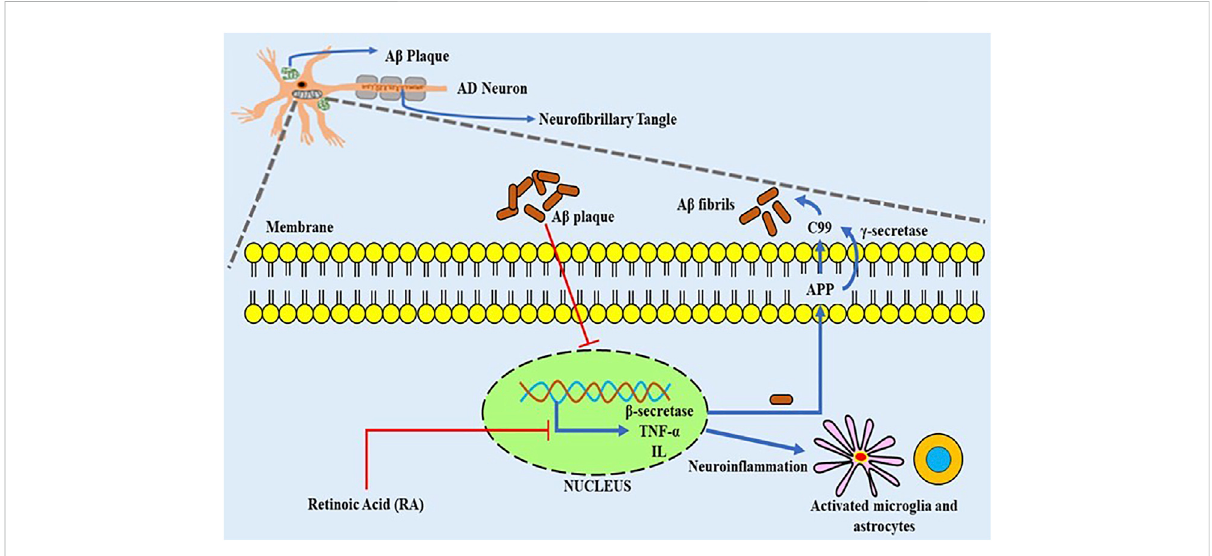
FIGURE 2 The overactivation of the ß- and Γ -secretases complexes may lead to the formation of Aß fi brils which successively leads to the generation of amyloid-ßplaquesandneuroin fl ammationbyactivatingthepro-in fl ammatorycytokineslikeTNFandIL.Suchtypeofoveractivationcanbeinhibited by the activity of retinoids like retinoic acid (RA). TNF- α , Tumour necrosis factor-alpha; IL, interleukins; Aß, amyloid beta; APP, Amyloid precursor protein; C99, carboxyl fragment